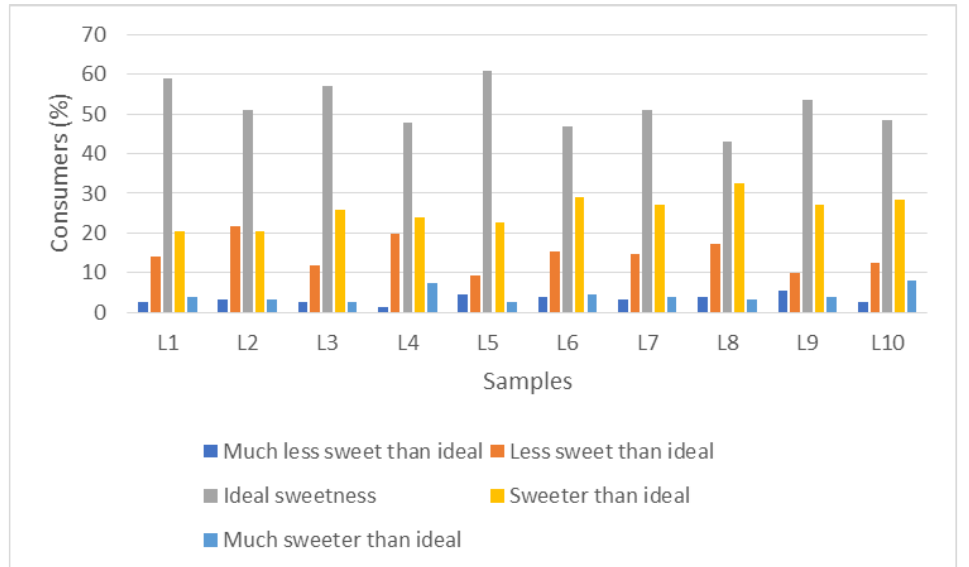
Figure 2. Histogram with the distribution of responses in the ideal test for the label samples. L1 (Orange color label with sweeteners), L2 (White color label with sweeteners), L3 (Yellow color label with sweeteners), L4 (Blue color label with sweeteners), L5 (Green color label with sweeteners), L6 (Orange color label with sucrose), L7 (White color label with sucrose), L8 (Yellow color label with sucrose), L9 (Blue color label with sucrose), L10 (Green color label with sucrose). Each column represents the mean percentage frequency ([the number of participants who selected each term from the scale] × 100/[the total number of participants]) for the ten